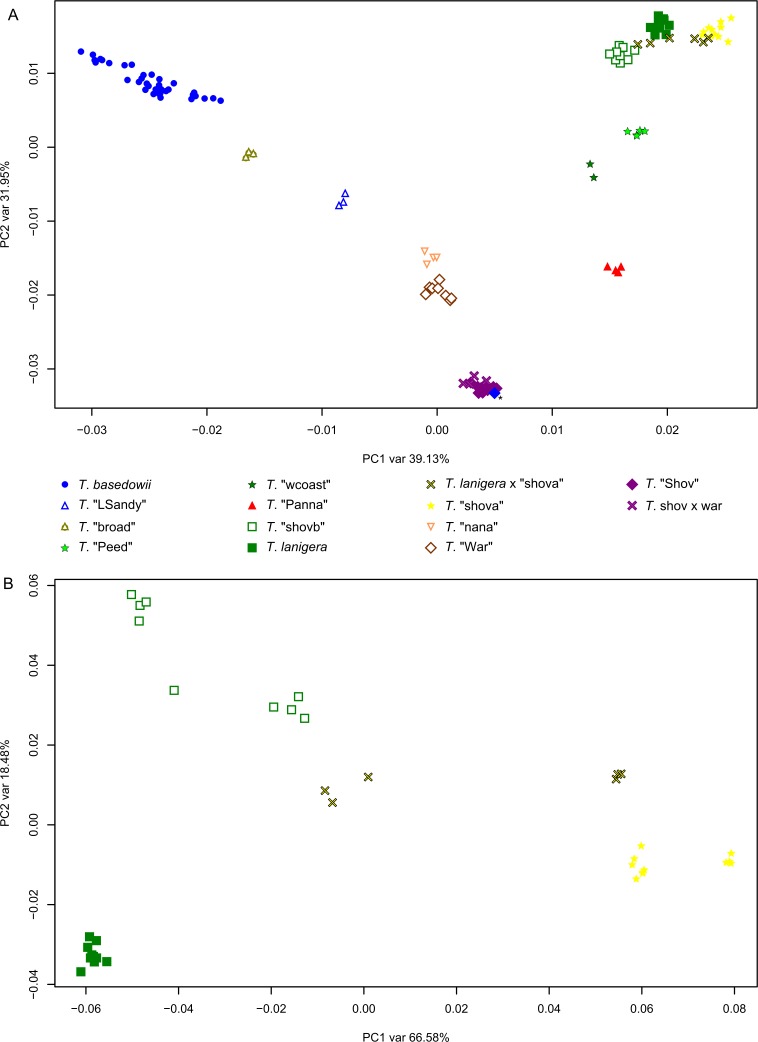
Principal coordinates analysis of samples from the Triodia basedowii complex.A) all samples, using 119,449 SNPs following filtering for 50% minimum taxon coverage and removing invariant SNPs; B) samples of T. lanigera, T. "shovb", T. "shova" and putative hybrids between them, using 44,365 SNPs after filtering as in A. The asterisked sample is likely mislabelled as T. basedowii (co-occurring).